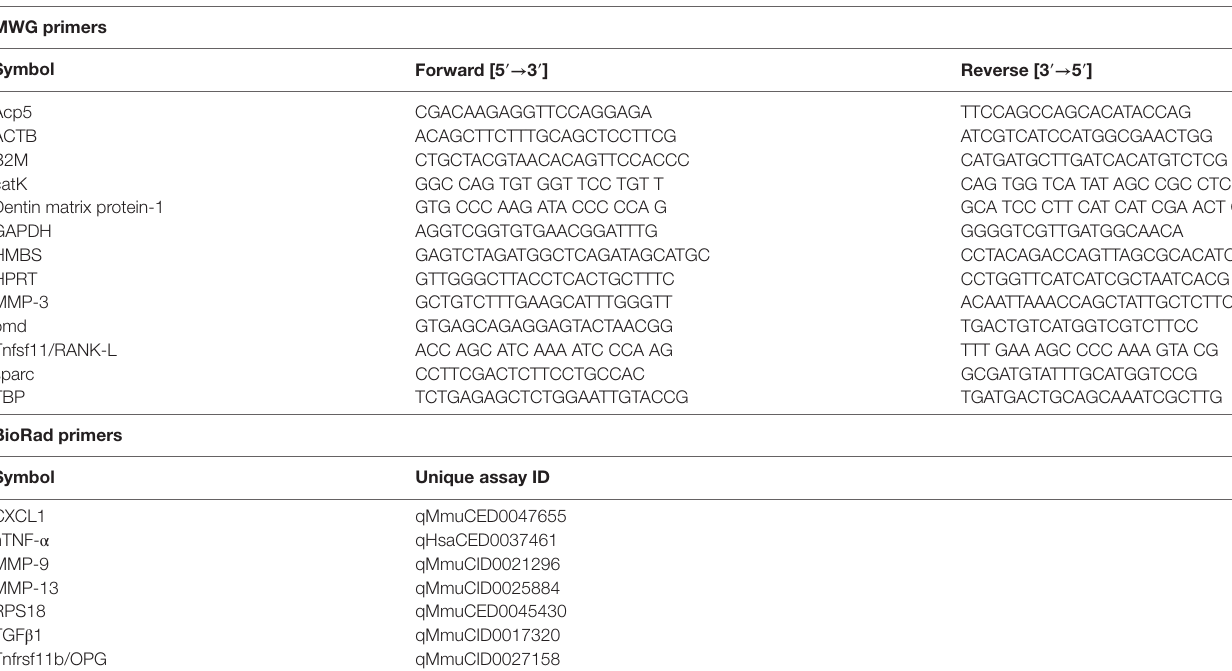
TaBle 1 | List of self-designed and commercially obtained primers with the respective sequences or assay IDs. MWg primers symbol Forward [5 ′→ 3 ′ ] reverse [3 ′→ 5 ′ ]